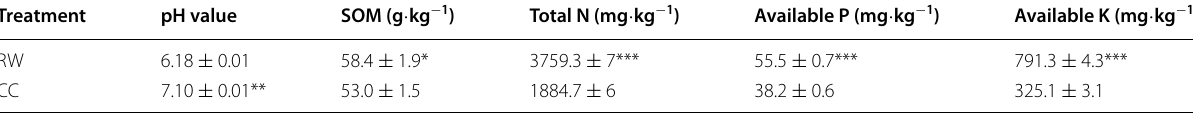
DATA means SE, n 3. Significant differences were determined using least significant differences (LSD ± = SOM soil organic matter, total N total nitrogen, available P available phosphorus, available K available potassium *, **, and *** indicate significant difference at P -values in 0.05, 0.01, and 0.001 level of probabilities, respectively Table 3 Correlations of rhizosphere soil microbial populations with physicochemical parameters of RW in blue and CC in pink